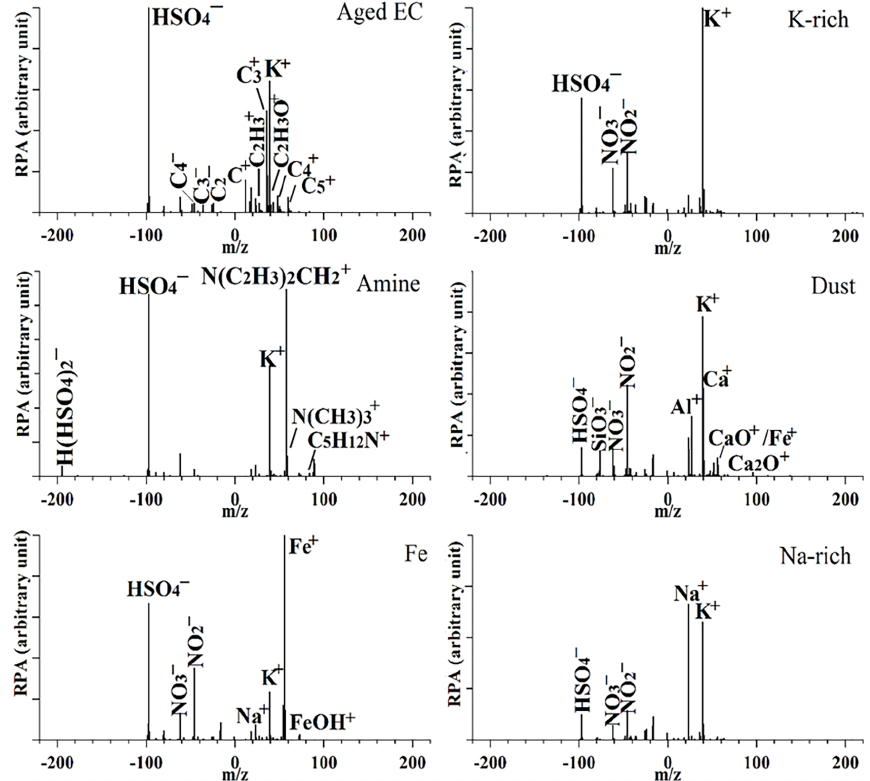
Figure 3. Averaged positive and negative mass spectra for the main six particle types (aged EC, K-rich, amine, dust, Fe and Na-rich) of the sampled particles. RPA on the vertical axis refers to relative peak area. On the horizontal axis, m/z represents mass-to-charge ratio.